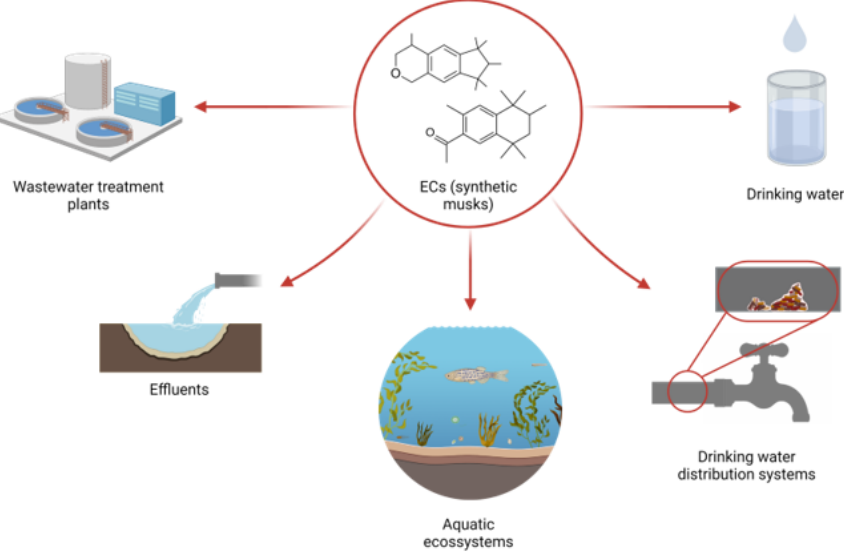
Figure 1. Main places of detection of musk contaminants in the